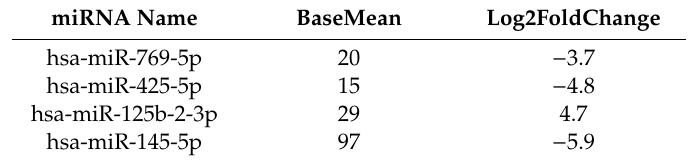
Table 3. miRNAs with differential expression upon osteoblastogenic differentiation (D7 vs. D0) in